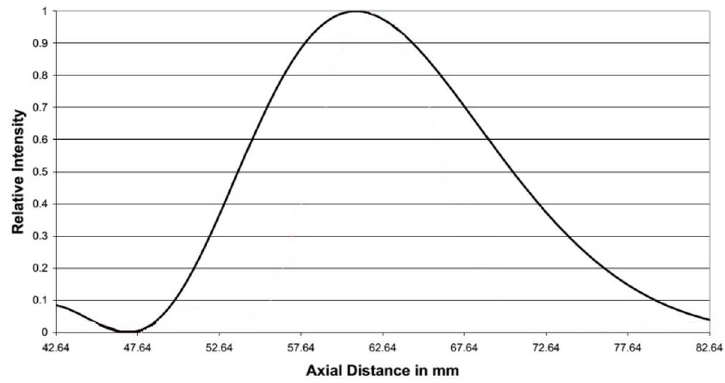
Fig 5. Relative intensity of the transducer along the axis for the fundamental frequency.